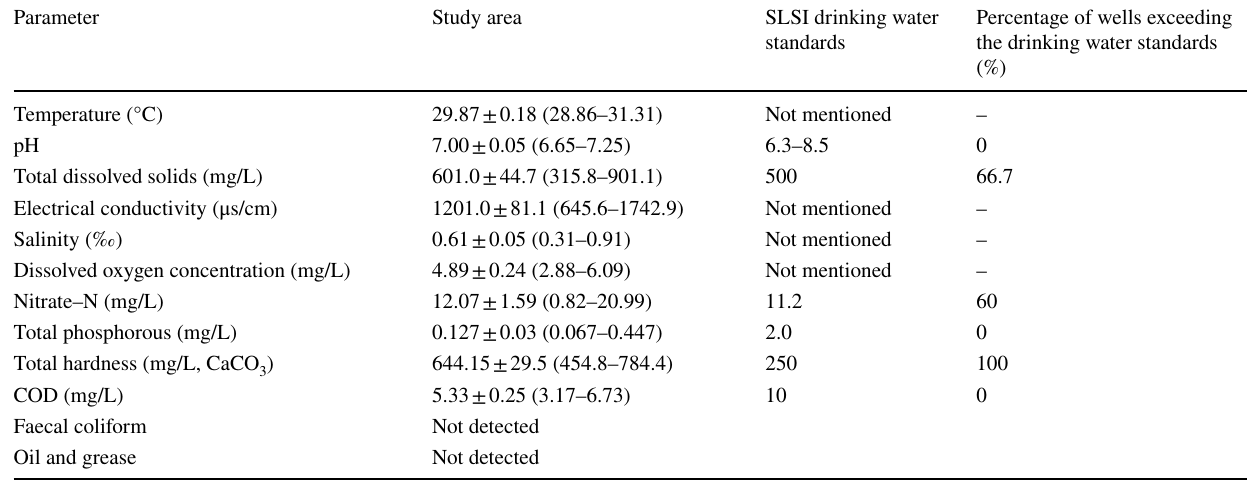
Table 1 Mean ± SD of water quality parameters of the domestic wells in Kondavil region during the study period, drinking water standards established by the Sri Lanka Standards Institution (SLSI 1983, SLSI